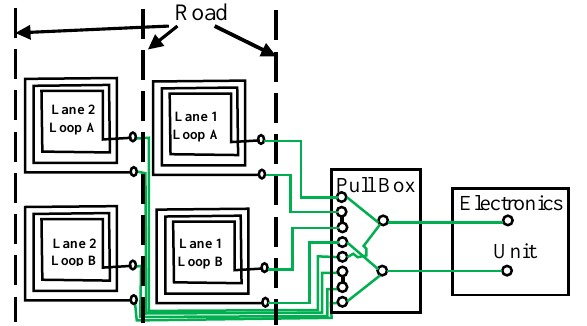
Figure 2. A detailed structure of Loop Configuration and connection with electronics unit through pull box.